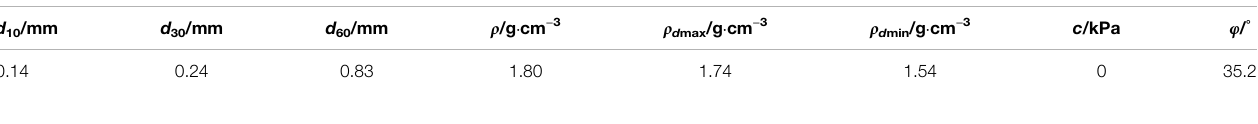
TABLE 2 | Basic properties of the test